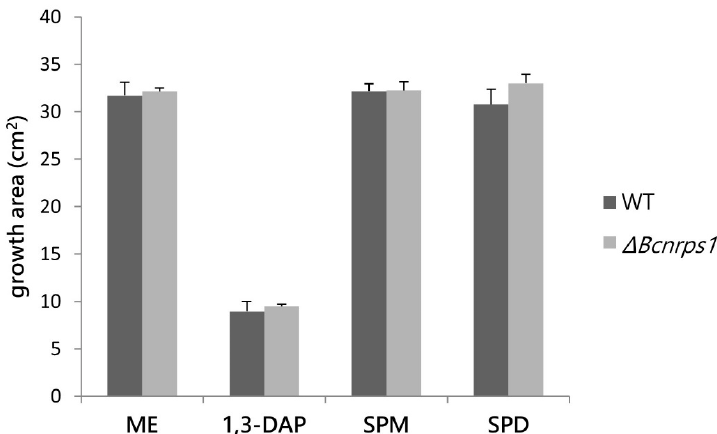
Figure 5. Influence of PAs on the growth area of the B. cinerea B05.10 strain (WT. gray) and ∆ Bcnrps 1 (light gray) 4 days post inoculation. ME: growth area in 0.2% ME medium without amended; 1,3-DAP, SPM, and SPD: growth area in ME medium amended with 1.5 mM, 10 μ M, and 350 μ M of each PA, respectively. Error bars represent standard deviations of means ( n = 3). No significant difference was found between strains or media type ( p > 0.05).